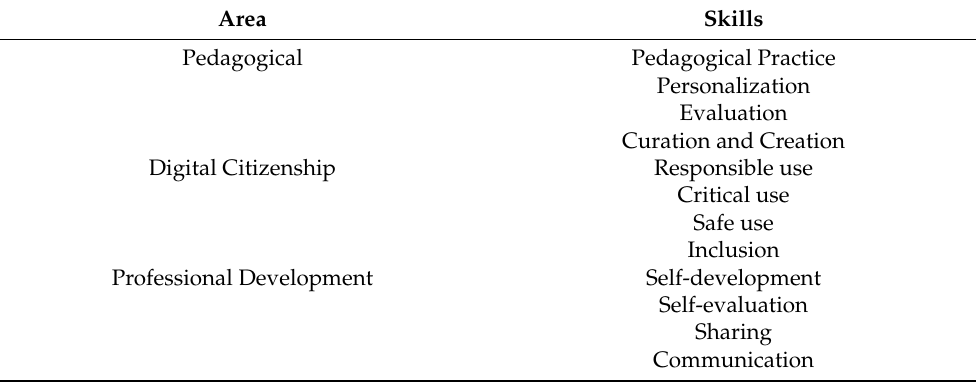
Table 2. Teaching skills areas to